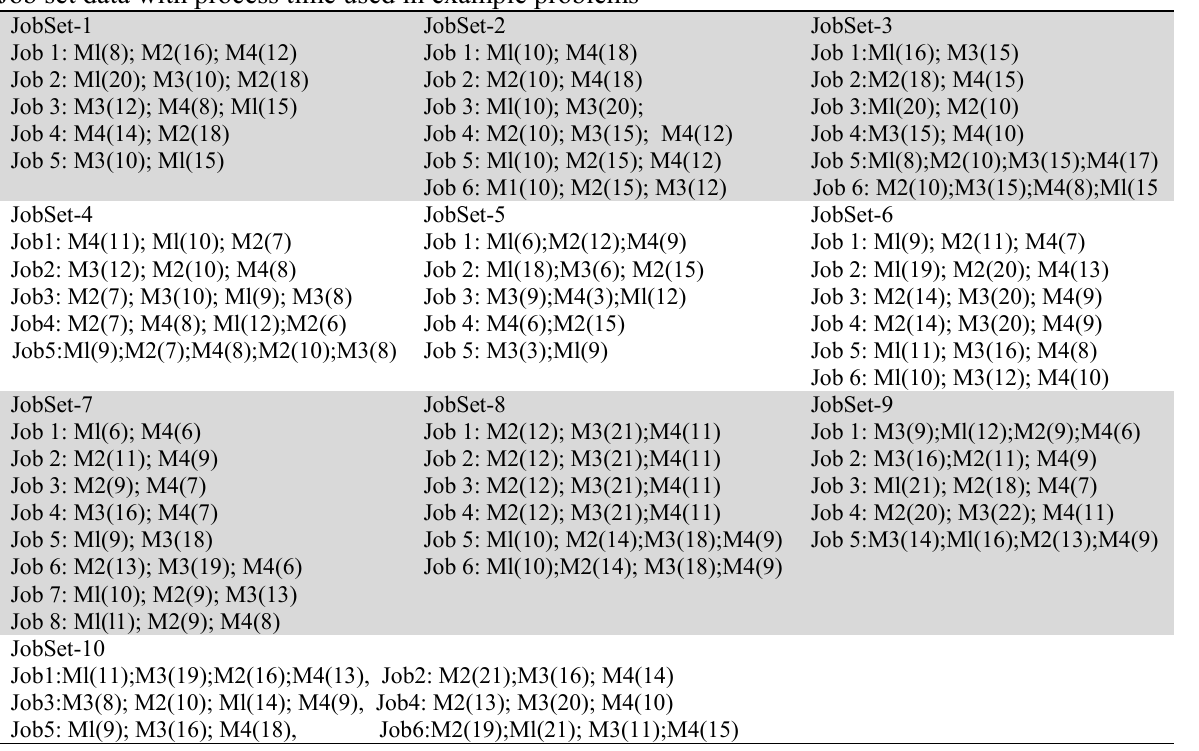
Job set data with process time used in example problems